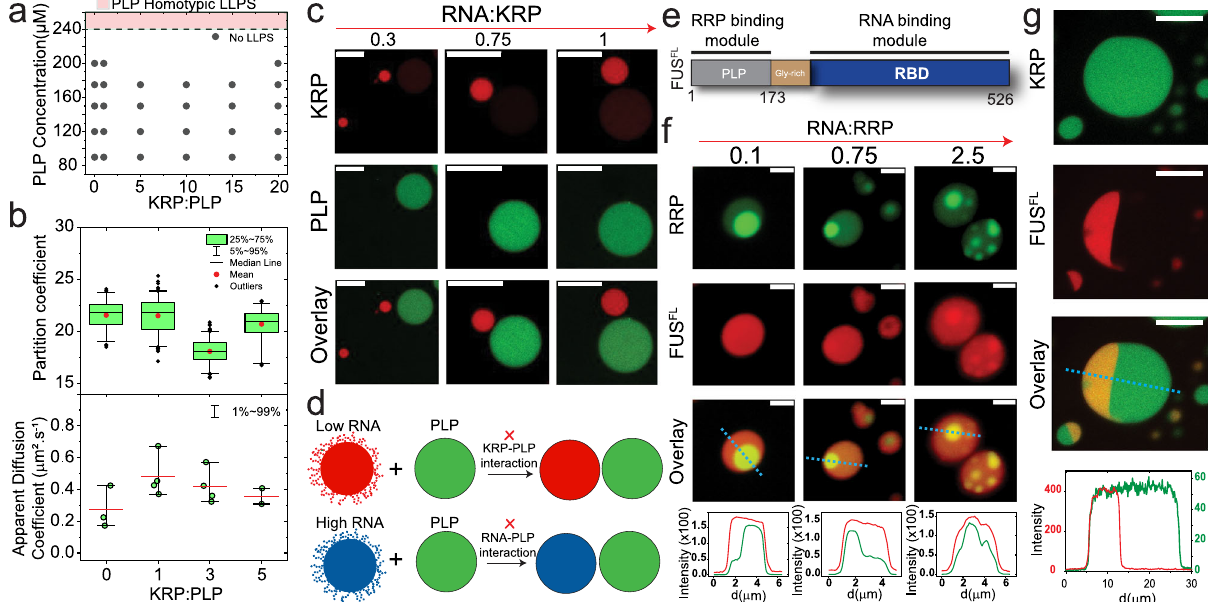
Fig. 5 Intermolecular interactions between RNA and protein components tune the morphology of coexisting condensates. a State diagram of PLP-KRP mixtures as a function of KRP-to-PLP ratio (mole: mole), showing that KRP, [KGKGG] 5 , does not affect PLP phase-separation (compare with Fig. 1a for RRP- PLP mixtures). b PLP partition coef fi cient ( n = 60 droplets per sample) and diffusion rate ( n = 3 droplets per sample) in PLP-KRP condensates as a function of KRP-to-PLP mixing ratio (mole: mole). The error bars represent the range of data (1 – 99%) for the bottom panel while the red line represents the mean value. Source data are provided as a Source Data fi le. c Fluorescence images showing that the morphology of coexisting PLP homotypic condensates and KRP-RNA condensates is non-engul fi ng and does not vary with RNA-to-KRP stoichiometry. Each type of droplet was separately prepared at initial concentrations of [FUS PLP ] = 400 µ M, [KGKGG] 5 = 4 mg/ml, and variable poly(rU) RNA-to-KRP ratios (wt/wt), as indicated, and mixed (1:1 vol/vol). d A schematic diagram showing that due to insigni fi cant KRP-PLP interfacial interactions, the PLP homotypic and KRP-RNA heterotypic condensates do not share any interface (non-engulfment) at both low and high RNA. e Domain architecture of FUS FL showing both PLP and RBD modules. f Fluorescence microscopy images and intensity pro fi les for coexisting homotypic FUS FL droplets (red) and heterotypic RRP-RNA condensates at different RNA-to-RRP ratio. Each type of droplet was separately prepared at initial concentrations of [FUS FL ] = 21.3 µ M, [FUS RGG3 ] = 1 mg/ml and variable poly(rU) RNA-to-RRP ratios (wt/wt), as indicated, and mixed (1:1 vol/vol). g Fluorescence micrographs and intensity pro fi les for Janus droplets formed by coexisting homotypic FUS FL droplets (red) and heterotypic KRP-RNA condensates (green). Each type of droplet was separately prepared at initial concentrations of [FUS FL ] = 22 µ M, [KGKGG 5 ] = 4 mg/ml and poly(rU) = 3 mg/ml and mixed (1:1 vol/vol). All samples were made in a buffer containing 25 mM Tris-HCl, 150 mM NaCl, and 20 mM DTT. Scale bars represent 10 µ m for ( c , g ) and 2 µ m for ( f